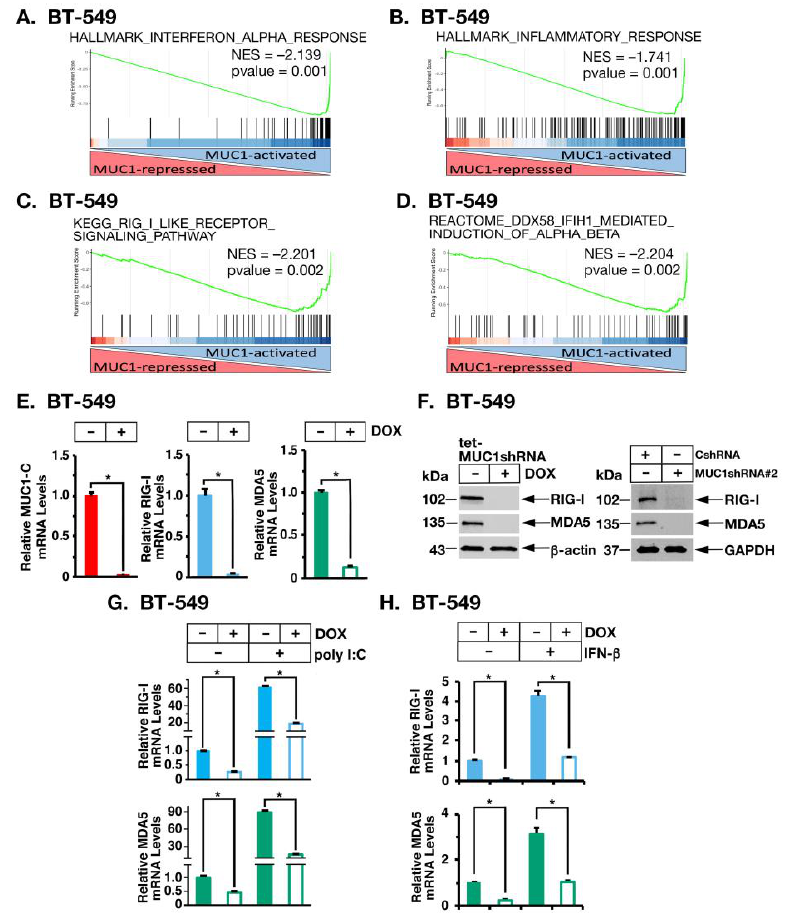
Figure 2. MUC1-C is necessary for induction of RNA PRRs . ( A – D ) RNA-seq was performed in triplicate on BT-549 cells expressing a tet-MUC1shRNA, which were treated with vehicle or DOX for 7 days. Candidate pathway enrichment plots for the HALLMARK INTERFERON ALPHA RESPONSE ( A ), HALLMARK INFLAMMATORY RESPONSE ( B ), KEGG RIG-I LIKE RECEPTOR SIGNALING ( C ) and REACTOME DDX58 IFIH1 MEDIATED INDUCTION OF INTERFERON ALPHA BETA ( D ) gene signatures. ( E , F ) BT-549/tet-MUC1shRNA cells were treated with vehicle or DOX for 7 days. MUC1-C, RIG-I and MDA5 mRNA levels were analyzed by qRT-PCR ( E ). The results (mean ± SD of 4 determinations) are expressed as relative mRNA levels compared to that obtained for vehicle-treated cells (assigned a value of 1). The asterisk (*) denotes a p -value < 0.05. Lysates were immunoblotted with antibodies against the indicated proteins ( F , left ). Lysates from BT-549/CshRNA and BT-549/MUC1shRNA#2 were immunoblotted with antibodies against the indicated proteins ( F , right ). ( G , H ). BT-549/tet-MUC1shRNA cells treated with vehicle or DOX for 7 days and stimulated with poly I:C for 12 h ( G ) or IFN- β for 4 h ( H ) were analyzed for RIG-I and MDA5 mRNA levels by qRT-PCR. The results (mean ± SD of 4 determinations) are expressed as relative mRNA levels compared to that obtained for vehicle-treated cells (assigned a value of 1). Uncropped Western Blots can be found at supplemental original